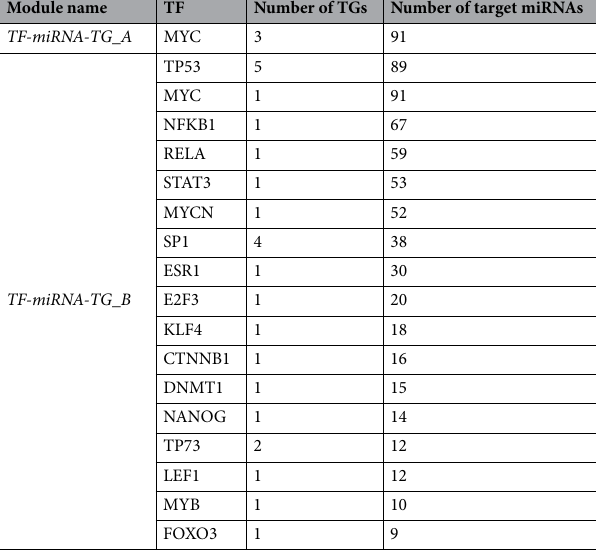
Table 2. High degree nodes of the TFs in the TF-miRNA-TG_A and B